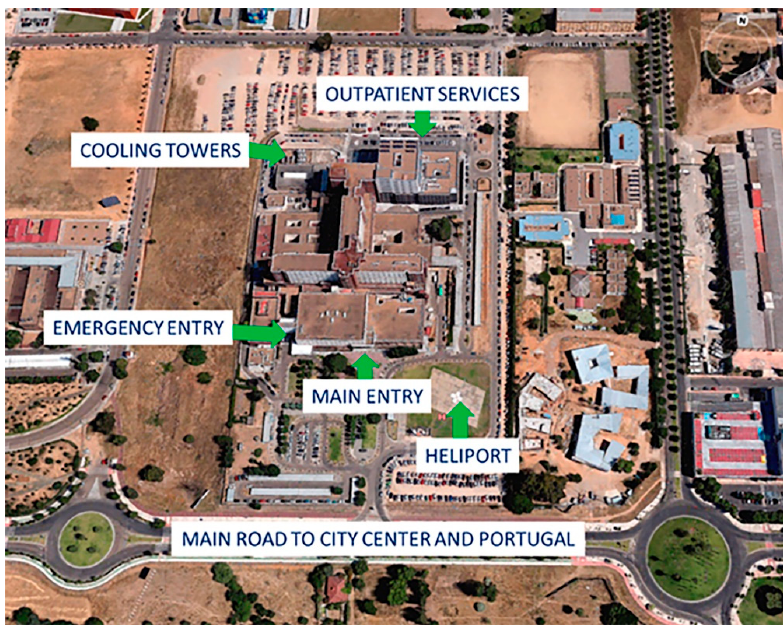
Figure 1. Aerial view of the University Hospital of Badajoz (Google Maps). North is shown at the upper right corner.